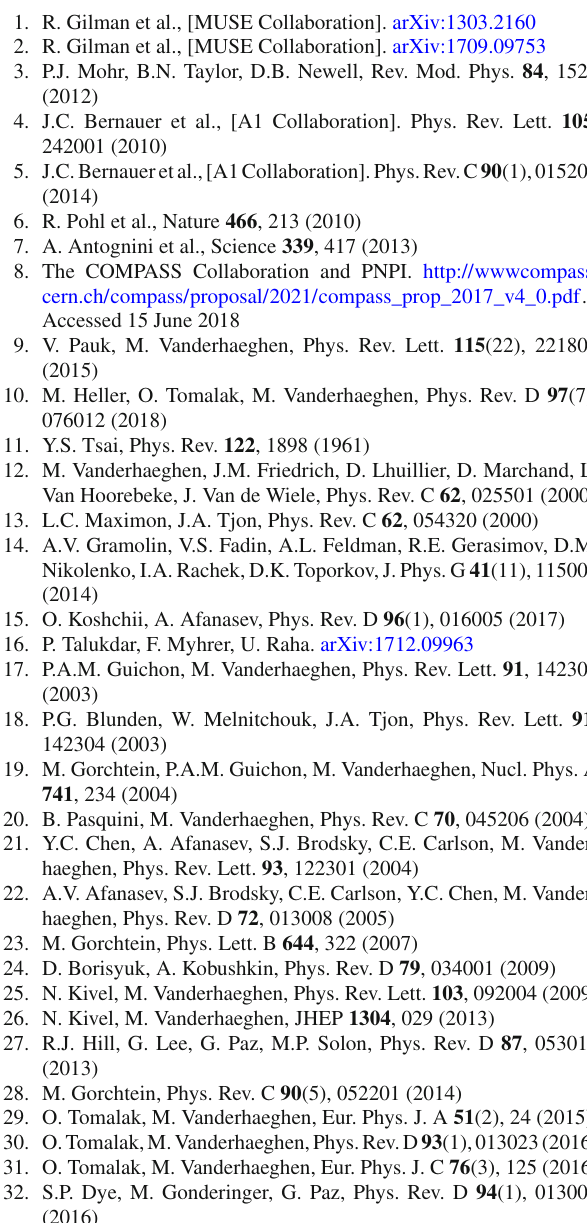
γ , G 2 γ , F 2 γ among the five 1 2 5